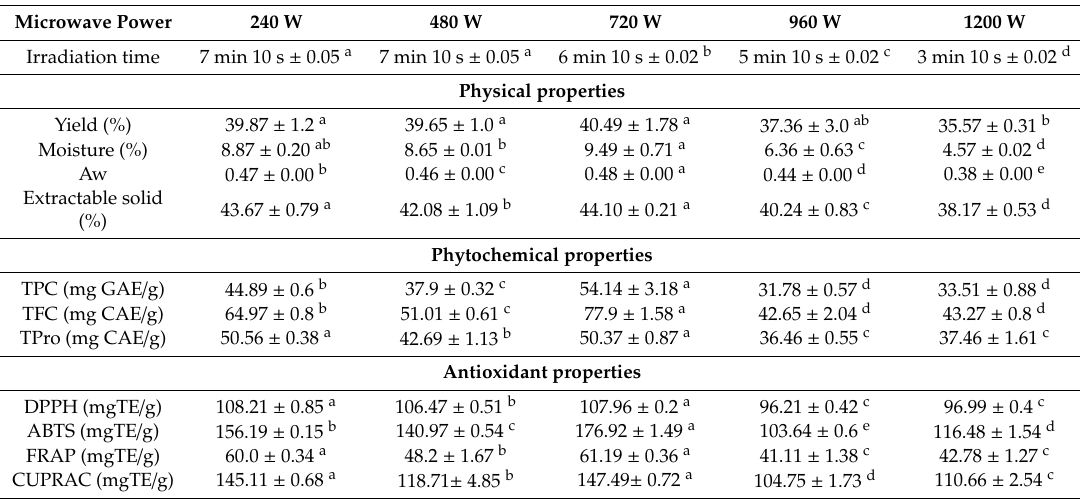
Table 1. Impact of microwave drying on physical, phytochemical and antioxidant property of Tuckeroo